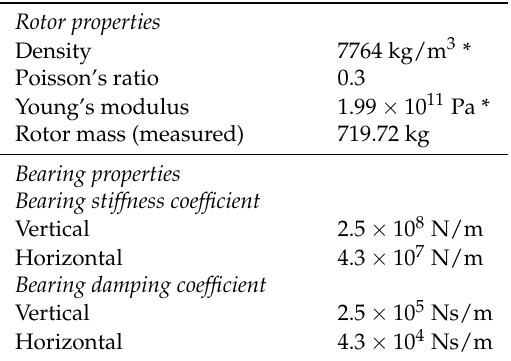
Table 4. Parameters of tube roll rotor-bearing